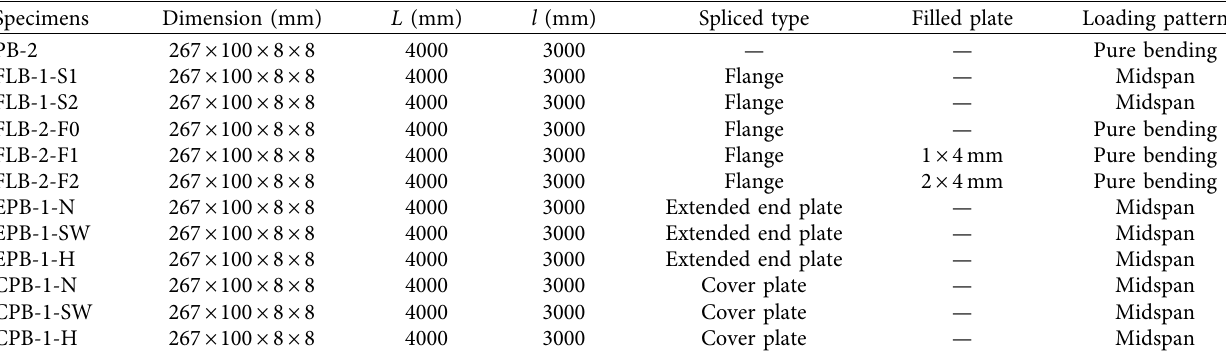
Table 1: Specimen